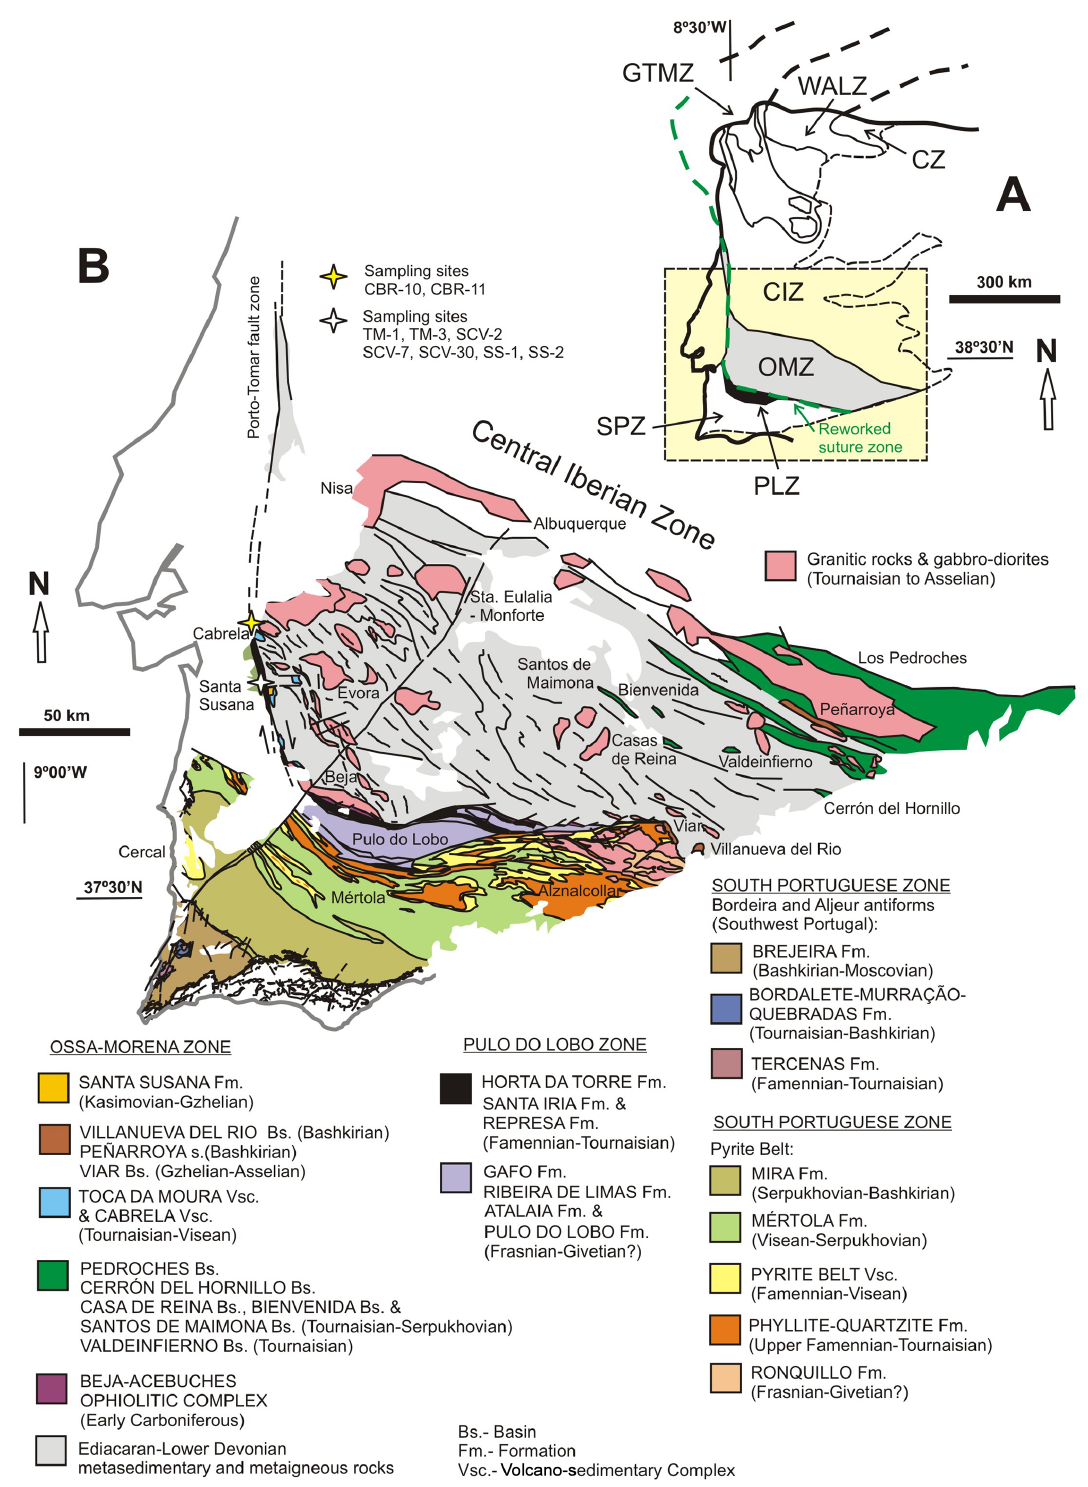
Figure 1. (a) Inset with location of SW Iberia in the Iberian Variscan belt with regional distribution of the main Paleozoic terranes: CIZ – Central Iberian Zone; CZ – Cantabrian Zone; GTMZ – Galicia-Trás-os-Montes Zone; OMZ – Ossa-Morena Zone; PLZ – Pulo do Lobo Zone; SPZ – South Portuguese Zone; and WALZ – West Asturian-Leonese Zone. (b) Simplified geological map of SW Iberia showing the South Portuguese, Pulo do Lobo, and Ossa-Morena zones (modified from Pereira et al., 2017a, 2019, and references therein; Quesada and Oliveira,